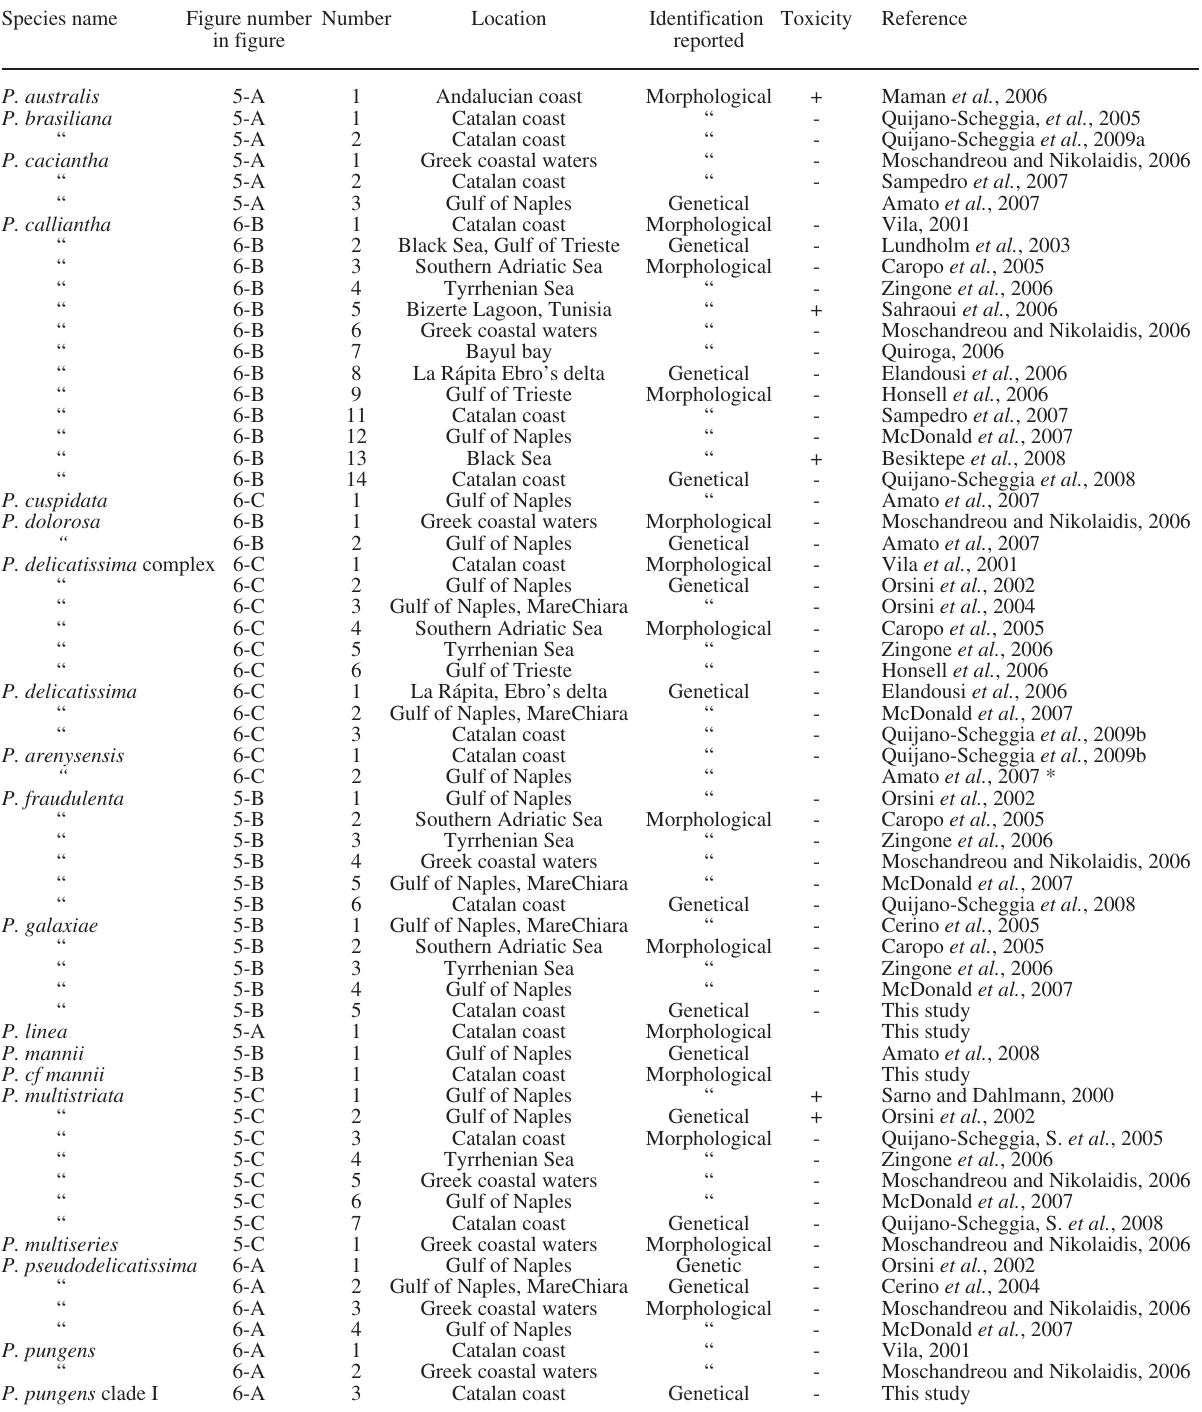
Table 6. – Reference list of the description of Pseudo-nitzschia in the Mediterranean Sea used in Figures 5 and 6. The procedures for species identification are indicated as either morphologic or genetic. Species name Figure number